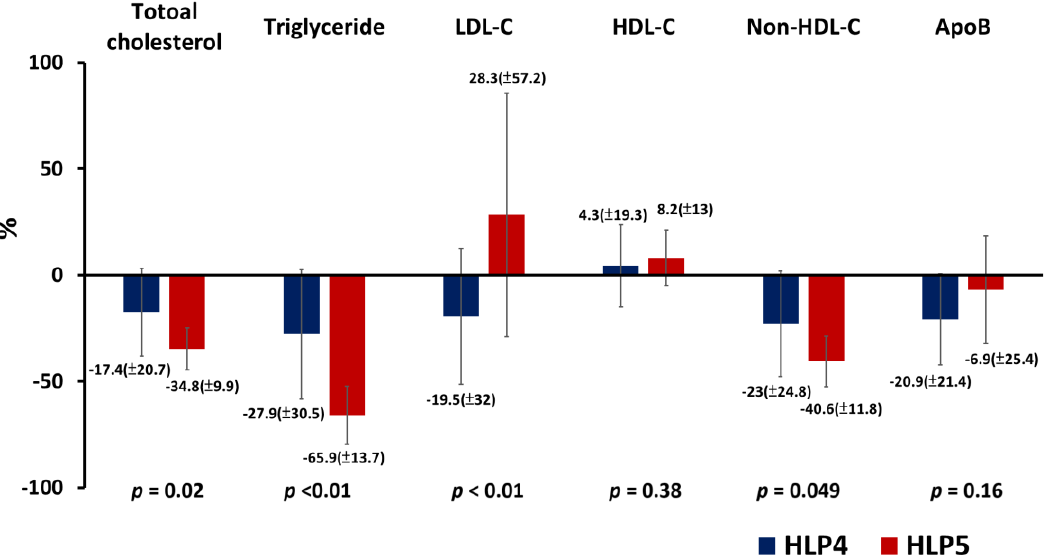
Figure 3. Percentage changes in each lipid parameter following the 6-month treatment in patients with HLP4 and patients with HLP5. ApoB = apolipoprotein B; HDL-C = high-density lipoprotein cholesterol; HLP4 = type IV hyperlipoproteinemia; HLP5 = type V hyperlipoproteinemia; LDL-C = low density lipoprotein cholesterol; N = number; Non-HDL-C = non-high-density lipoprotein cholesterol ( p value was calculated as HLP5 vs. HLP4).